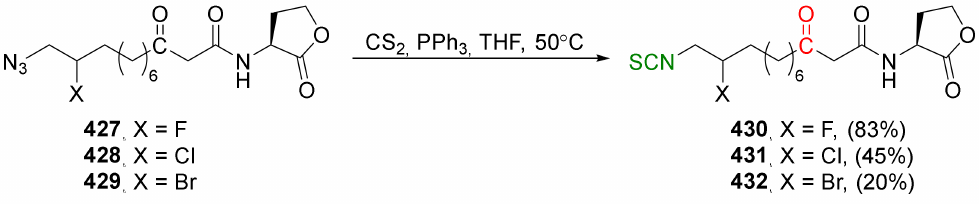
Figure 47. Synthesis of β -halo-ITCs 430 – 432